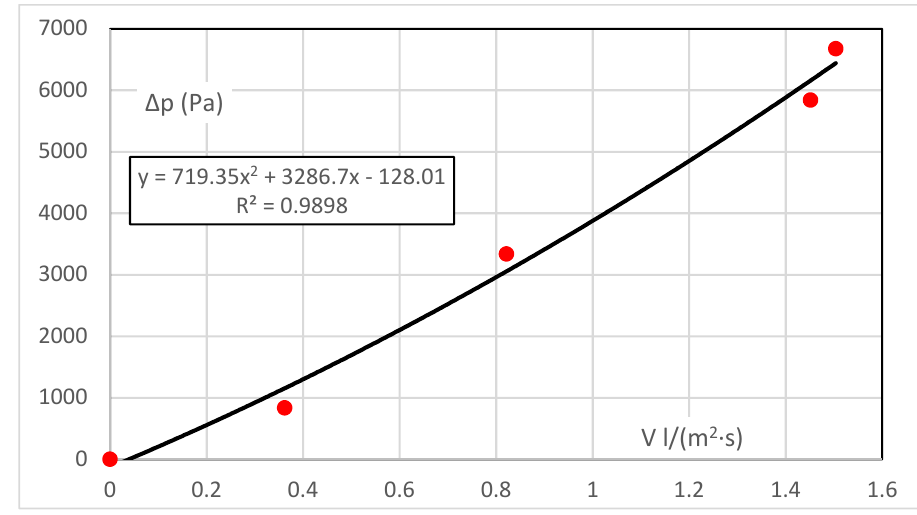
Figure 2. Resistance characteristic—vapour.